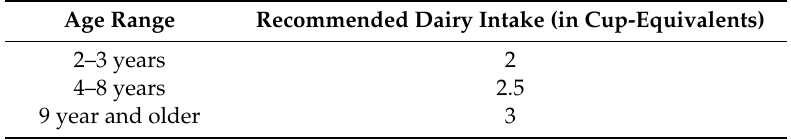
Table 1. Dairy intake recommendations from the 2015–2020 Dietary Guidelines for